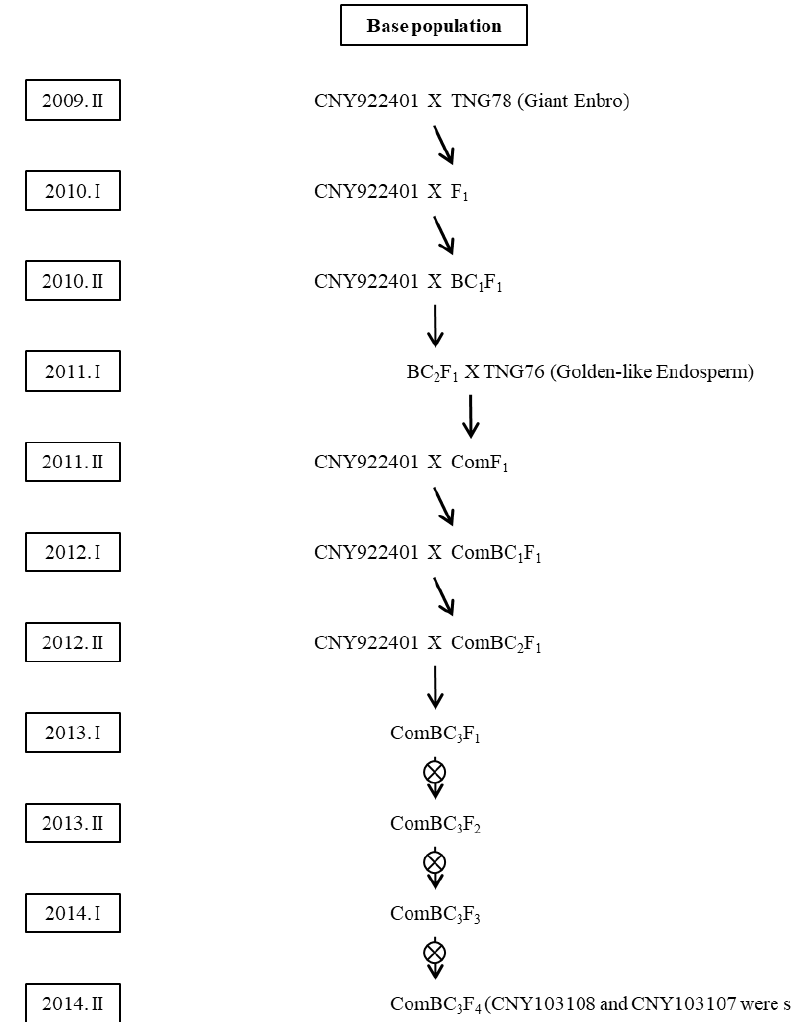
Figure 1. Breeding scheme for the base population.